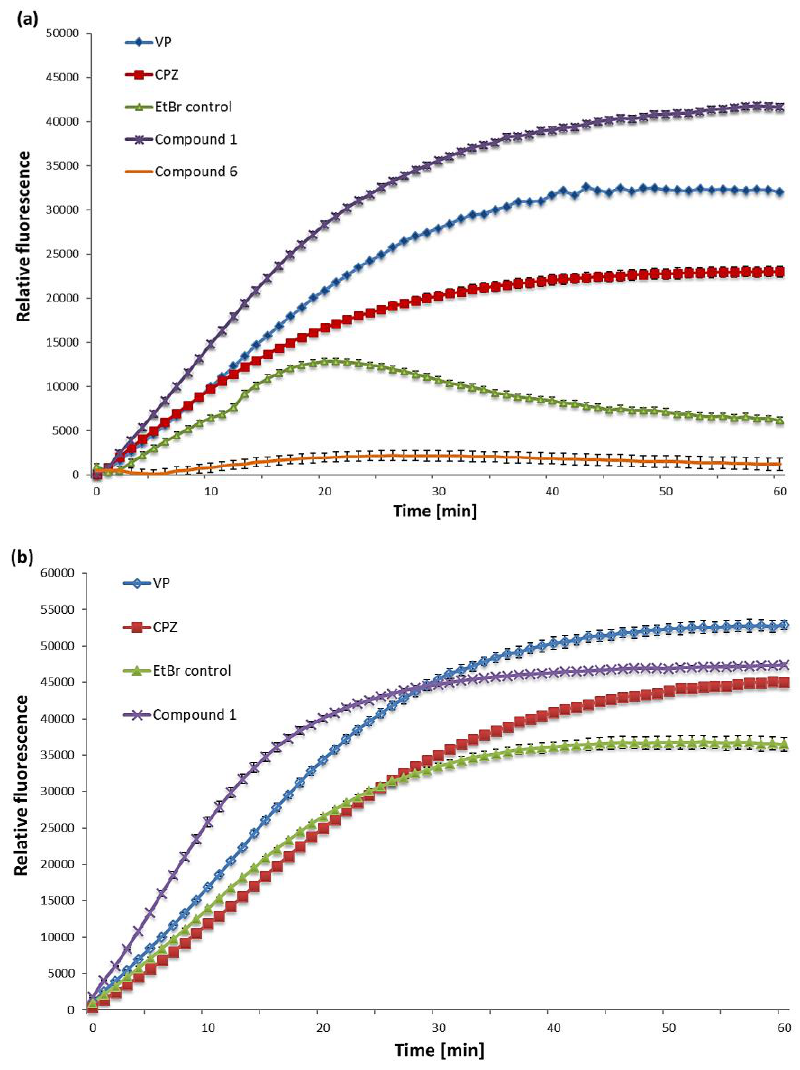
Figure 2. The increase of EtBr accumulation in M . smegmatis mc 2 155 ( a ) and M. aurum ATCC 23366 ( b ) generated by concentrations MIC / 2 of the potential e ffl ux pump inhibitors (EPIs) 1 and 6 and the reference inhibitors, verapamil (VP) and chlorpromazine (CPZ), included as two positive controls. EtBr, the negative control, was tested at 0.5 mg / L. The curves represent means ± standard deviations (SD); n = 3 .